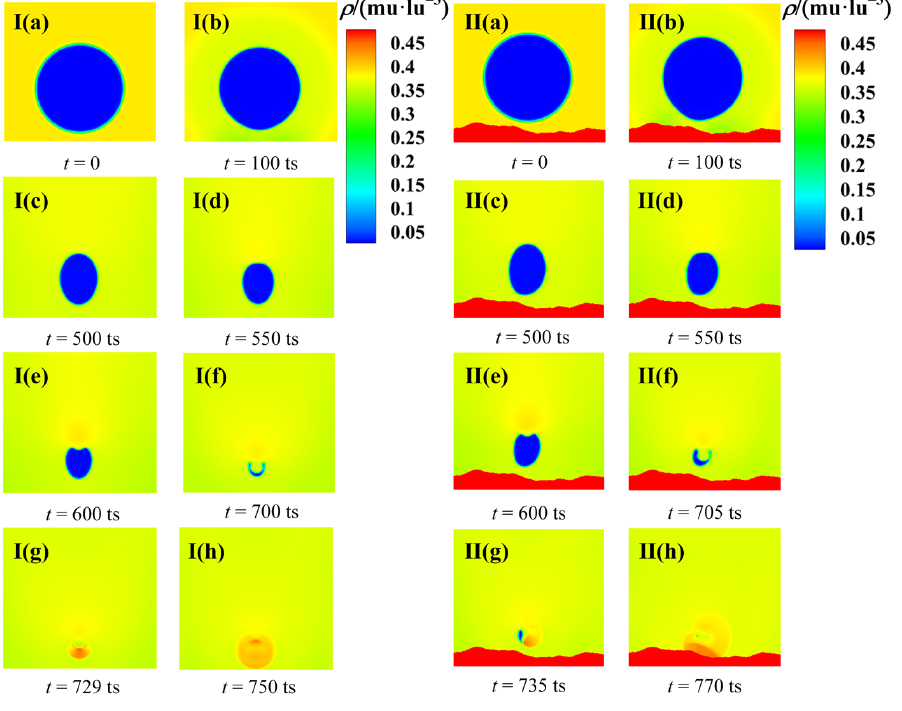
Figure 6. Evolution of density field of the collapsing bubble near a solid wall (( I ): plane solid wall and ( II ): solid wall with complex geometry).